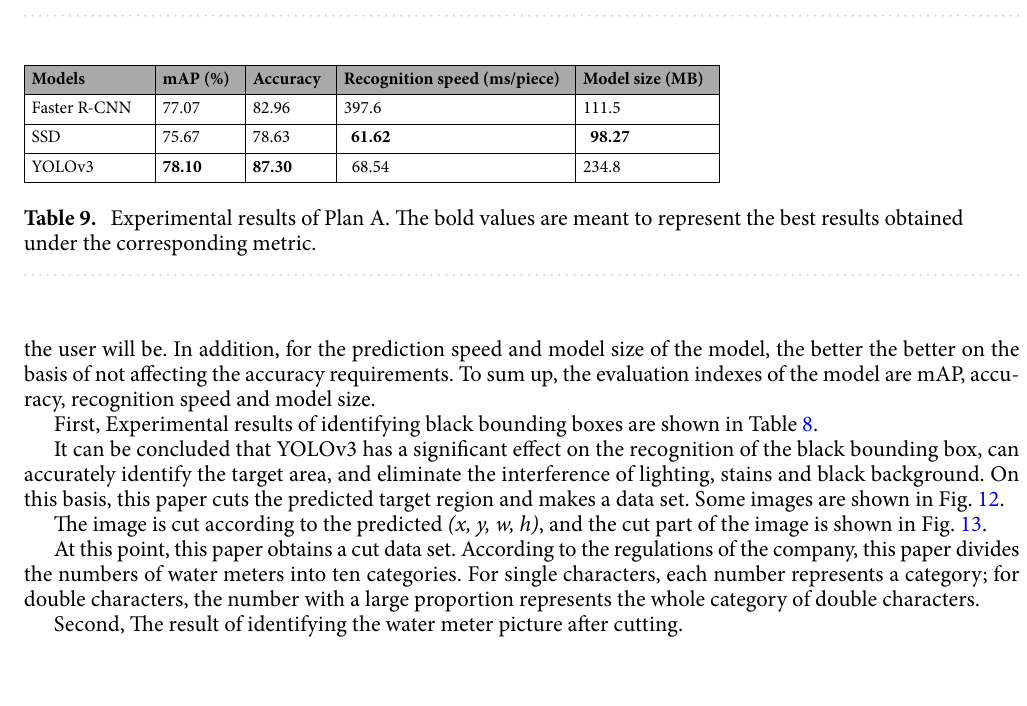
Figure 16. A partial rendering of the YOLOv3 test.